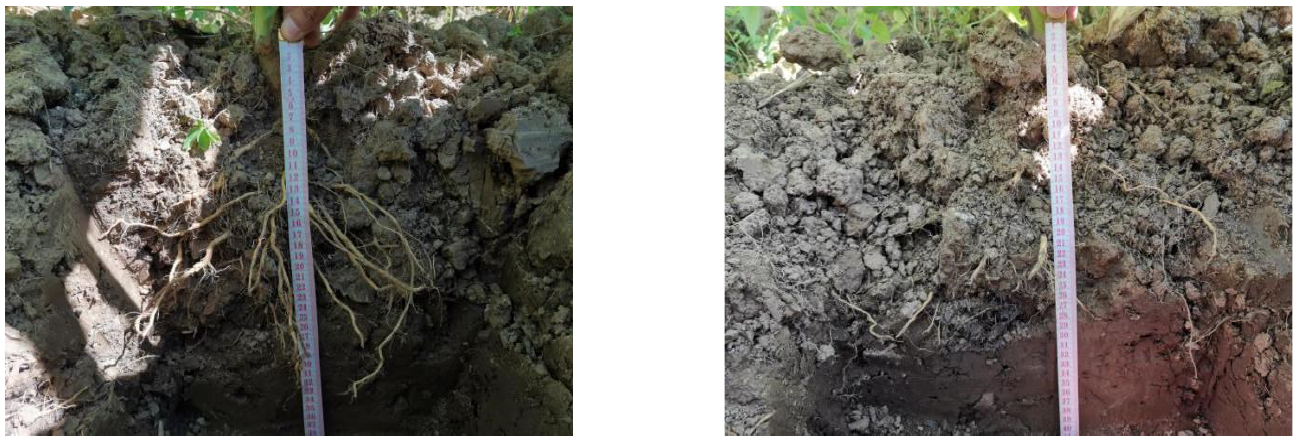
Figure 2. Comparison of root systems between DT and CK. Note: The left was for DT, and the right was for conventional tillage. Table 5. Influence of reduced nitrogen application on root depth and lateral root